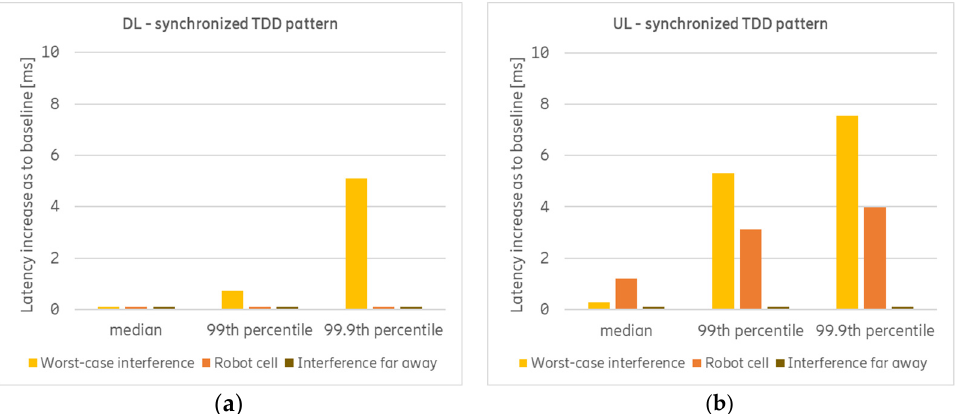
Figure 4. Increase in DL ( a ) and UL ( b ) latency compared to their baselines for synchronized TDD pattern of DDDDU with different indoor/outdoor UE deployment locations.